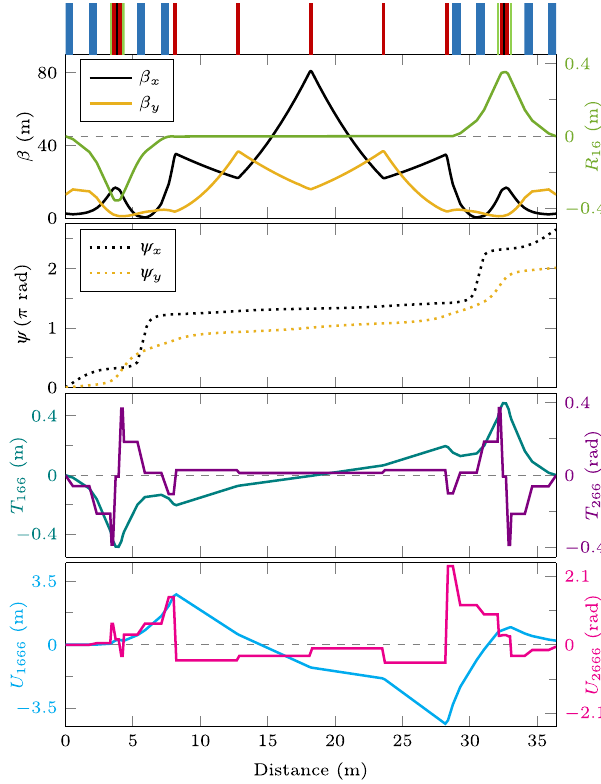
FIG. 4. CSR-mitigating and near-apochromatic BC. Again with compressor layout on top, followed by beta functions and T T dispersion, betatron phase advances, second-order spatial and 166 and 266 ), angular dispersion, and finally third-order spatial and angular dispersion. The added octupoles are shown in black. Note the Δ ψ ¼ 2 π phase advance between achromat x